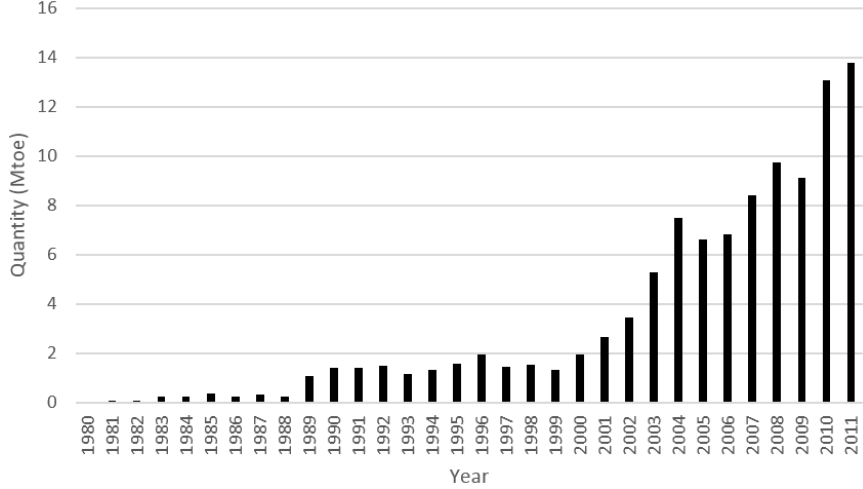
Figure 24. Coal import in Malaysia from 1980 to 2011